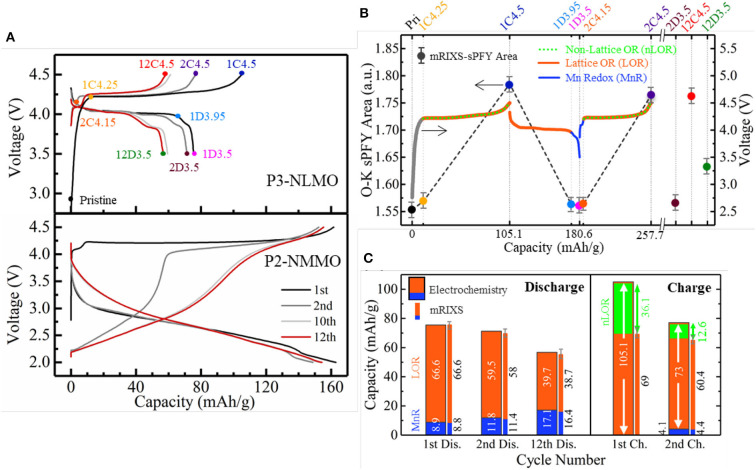
A comparative study on Na0.6Li0.2Mn0.8O2 (NLMO) and Na2/3Mg1/3Mn2/3O2 (NMMO). (A) Cycling profiles of NLMO and NMMO. (B) Differentiation of three redox reactions in NLMO during cycling. (C) Capacity contributions from three redox activities that are quantified based on electrochemical capacity (wide bar) and mapping of resonant inelastic X-ray scattering (mRIXS) results (thin bar). Reprinted from Wu et al. (2020b) with no permission required from authors.